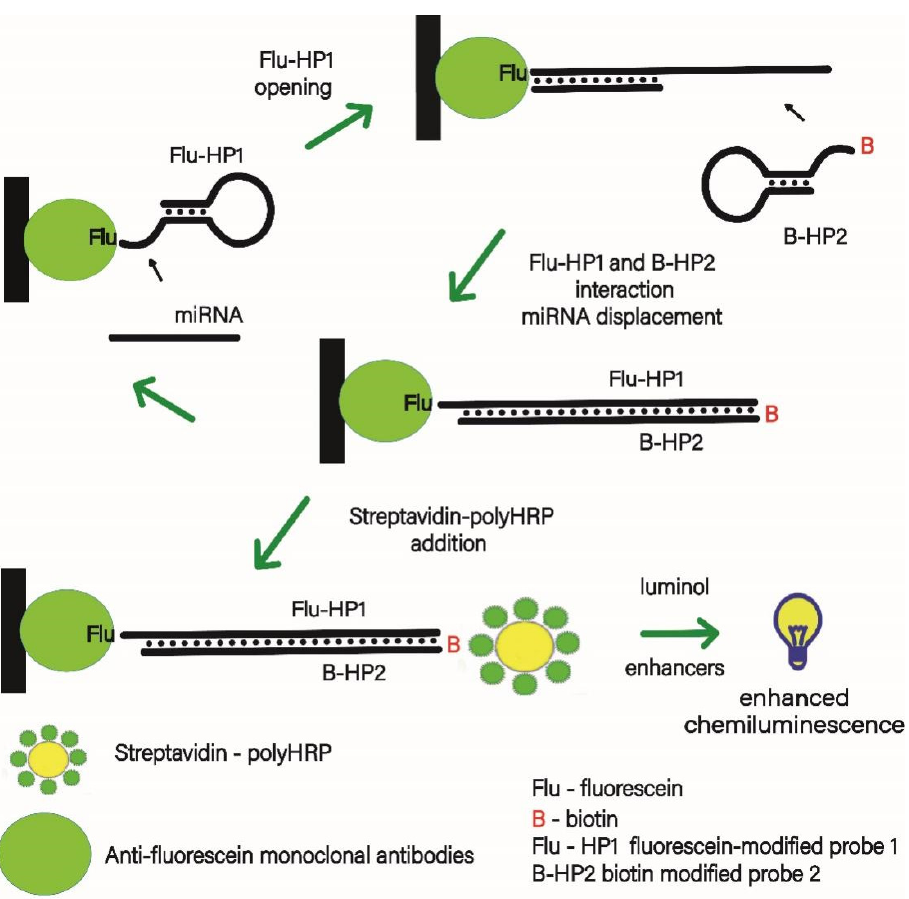
Figure 1. Scheme of the chemiluminescent heterogenous microRNA-155 assay coupled with mis- matched catalytic hairpin assembly amplification.